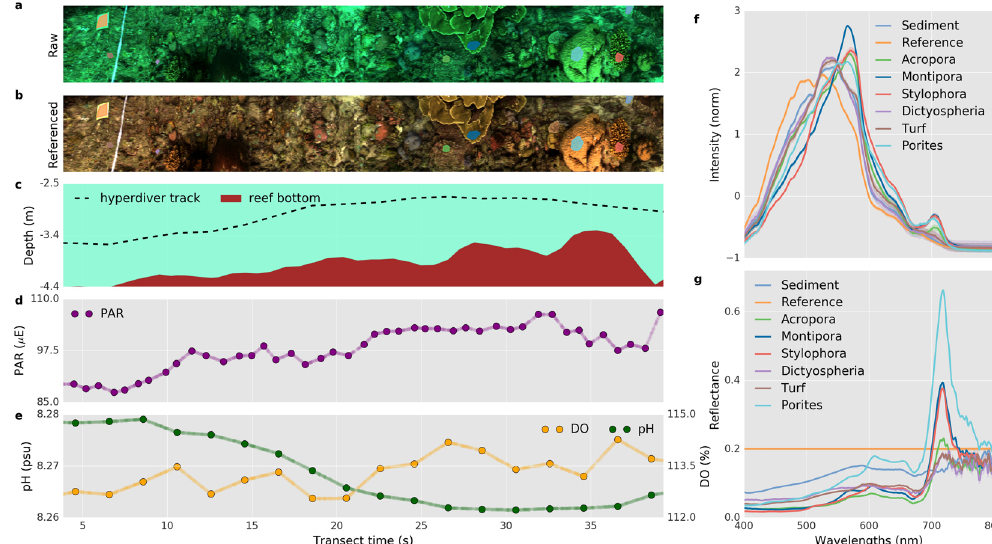
Figure 2. A HyperDiver survey transect delivers a multi-faceted dataset. ( a ) The measured scene visualized as a 3-channel color image derived from the hyperspectral data. ( b ) The same scene after reference-correction of spectra (plastic board, top left in scene) provides a true-color view of the benthos. ( c ) Depth and altitude information in combination generate a topographic profile of the bottom along the transect, useful to calculate rugosity. Additional sensors measured the ( d ) PAR intensity, ( e ) dissolved oxygen and pH over the transect. The transect scene covered ~16 m 2 in ~35 seconds with 1–2 cm resolution. Regions of interest (colored polygons in A and B) were selected in the scene to derive the average spectral intensity ( f ) and reflectance ( g ) of specific benthic